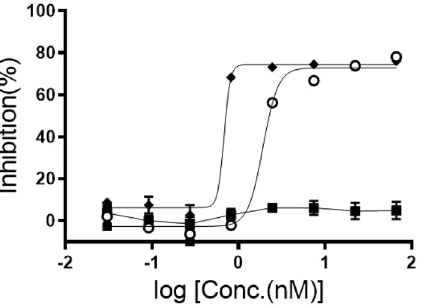
Figure 5. In vitro cancer cell killing activity of ADCs using SK-BR-3 cells. The IC 50 values of ADC1 (open circle) and ADC2 (diamond) were 1.9 and 0.7 nM, respectively, against > 66.7 nM (square) for the control determined based on the data (mean ± SEM, n ≥